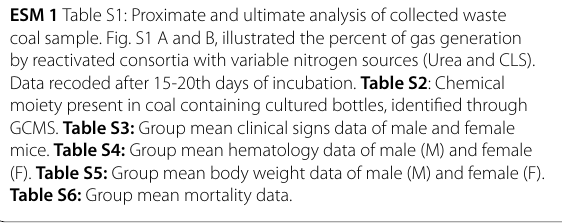
ESM 1 Table S1: Proximate and ultimate analysis of collected waste coal sample. Fig. S1 A and B, illustrated the percent of gas generation